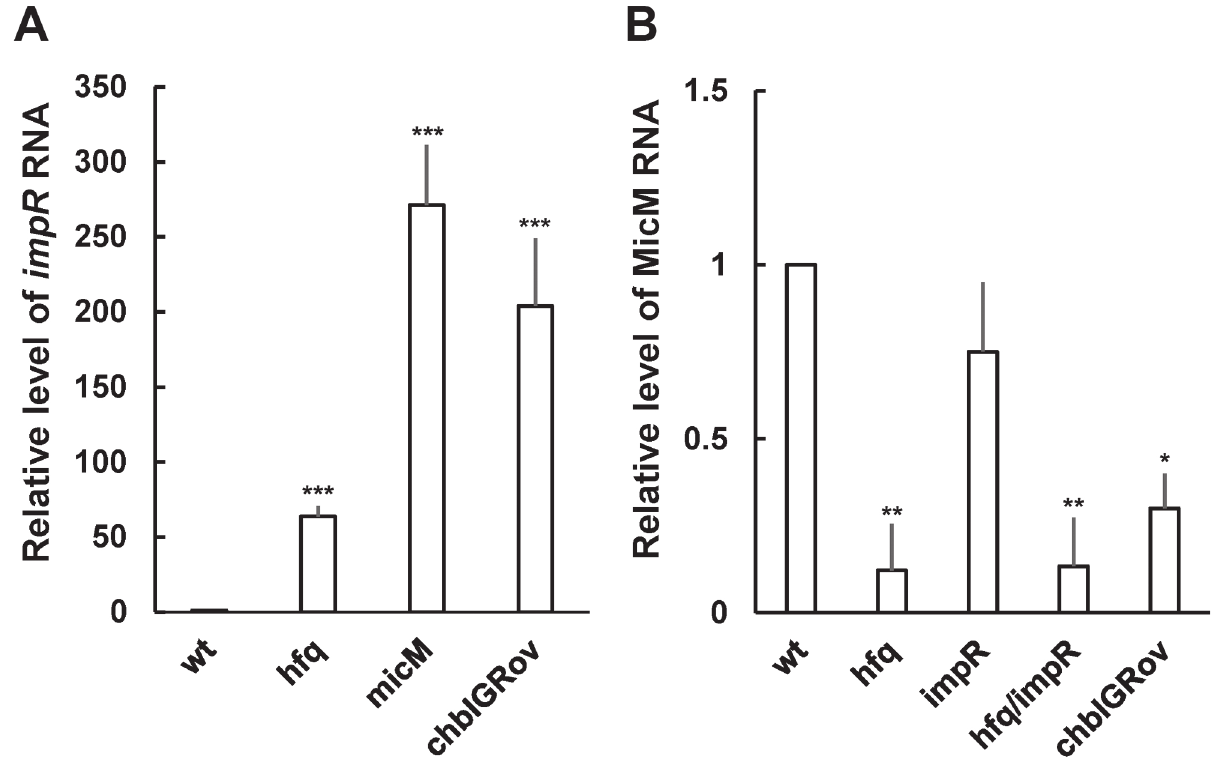
Fig 2. The RNA levels of impR (A) and MicM (B) in the wild-type P. mirabilis and its derived strains. The relative RNA levels of impR in the wild-type, mutants of hfq and micM , and chbIGRov were quantified by real-time RT-PCR. The RNA was prepared using overnight bacterial cultures. The relative RNA levels of MicM in the wild-type, mutants of hfq, impR and hfq/impR , and chbIGRov were also determined in the same way. The expression level for the wild- type cells was set at 1. The data represent the averages of three independent experiments with standard deviations. Significant difference from the wild-type was indicated with the asterisk ( * , P < 0.05; ** , P < 0.01; *** , P < 0.001 by Student ’ s t-test analysis). wt, wild-type; hfq, hfq mutant; impR, impR mutant; hfq/ impR, hfq and impR double mutant; chbIGRov, chbBC -IGR overexpressing strain; micM, micM mutant.